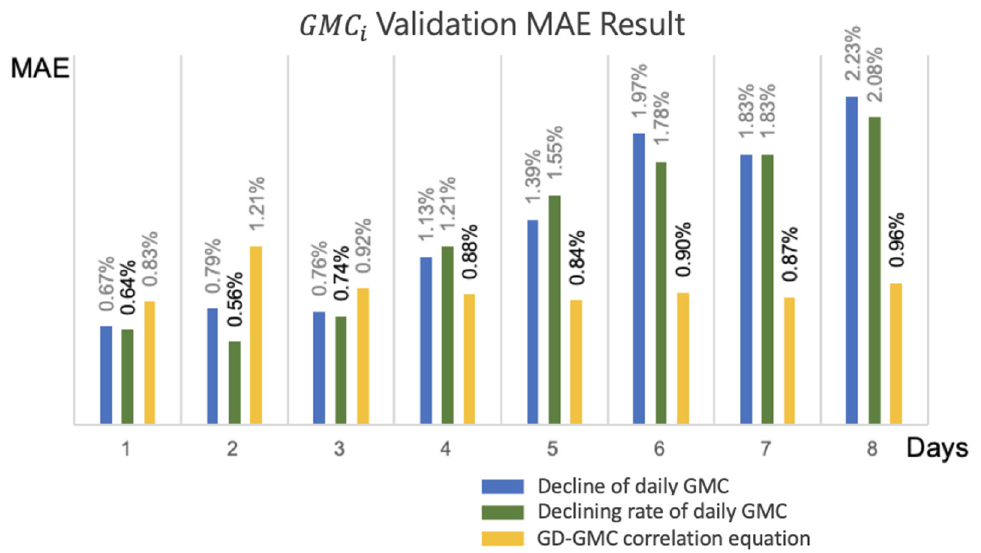
Sensors 2021 , 21 , x FOR PEER REVIEW Figure 18. Multi-day validation data for (cid:1833)(cid:1839)(cid:1829) (cid:3036) MAE evaluation. Figure 18. Multi-day validation data for GMC